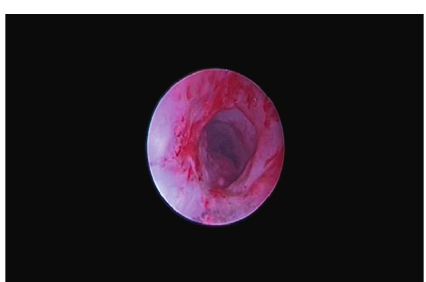
Figure 7: Grade I tracheal